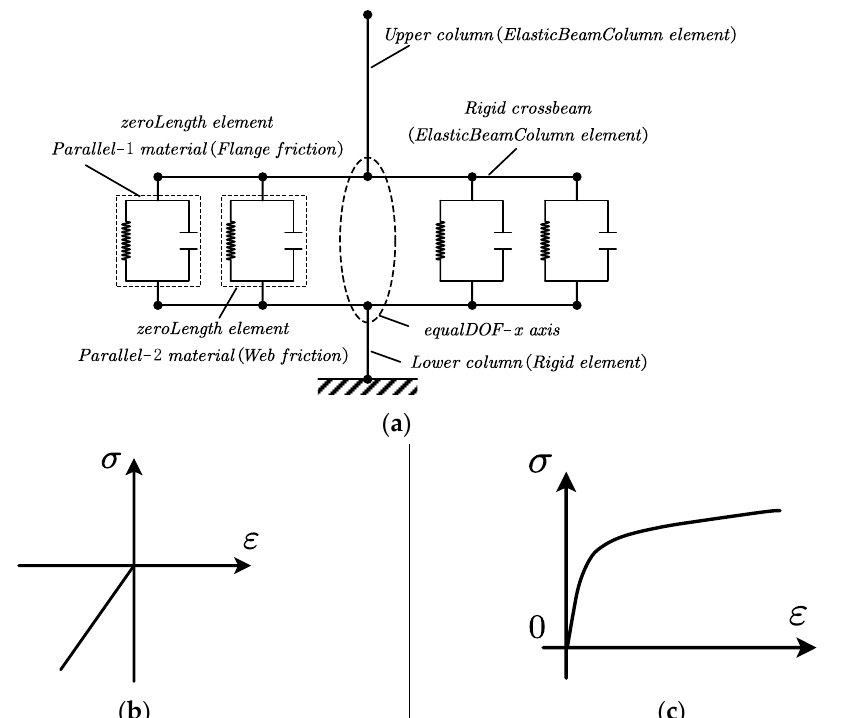
Figure 5. Establishment of the CPSFC: ( a ) Finite element model of CPSFC in OpenSees; ( b )ENT material in OpenSees; ( c ) Steel02 material in OpenSees.